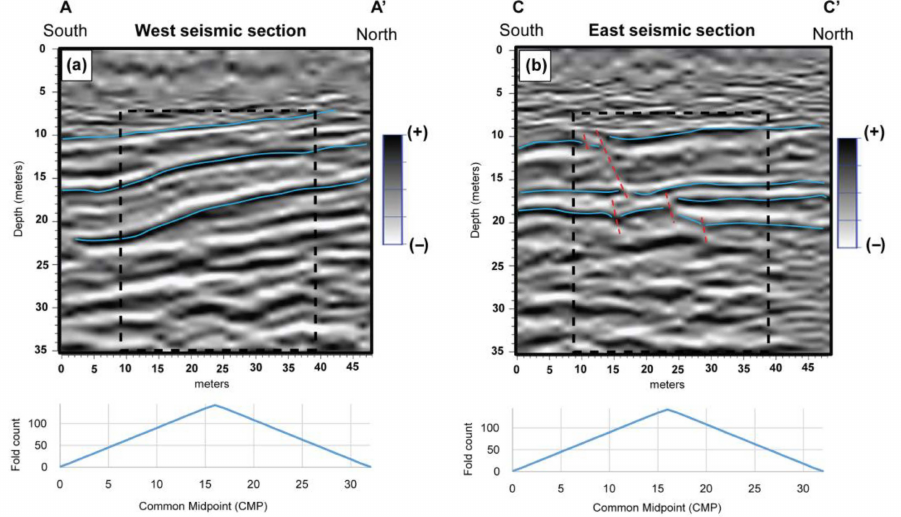
Figure 5. ( a ) West CMP shear-wave seismic reflection profile (A-A’) at 25 m from levee toe. ( b ) East CMP shear-wave seismic reflection profile (C-C’) at 355 m from levee toe. Rectangles with dashed lines represent the zone where the velocity analysis has a usable fold. Solid interpreted lines represent continuous seismic reflectors. Dashed lines represent cracks.